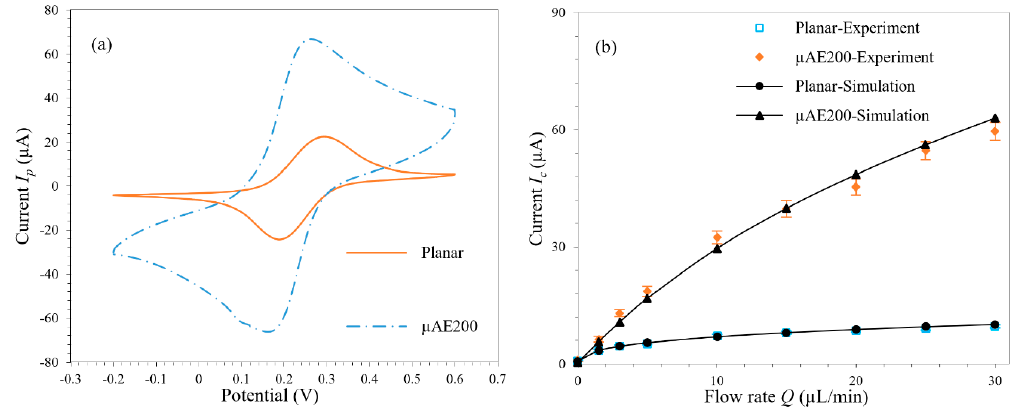
Figure 9. ( a ) Experimental CV of the planar microelectrode and μ AE200 at the scan rate of 0.05V/s; ( b ) Experimental and simulated current response of the planar microelectrode and μ AE200 at different flow rates; In the 5 mM K 3 [Fe(CN) 6 ]/K 4 [Fe(CN) 6 ] solutions with 0.1 M KCl vs Ag/AgCl.